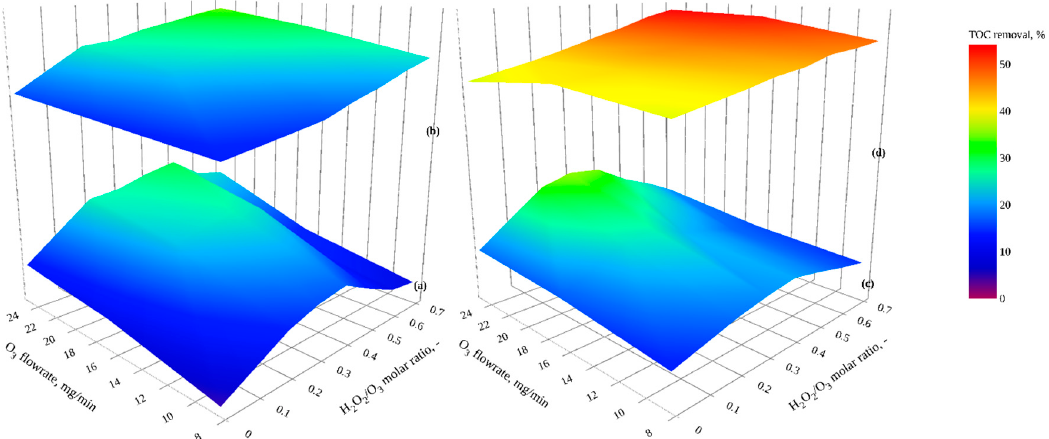
Figure 7. E ff ect of H 2 O 2 / O 3 molar ratios and TiO 2 loading on TOC reduction by ( a ) peroxonation, ( b ) catalytic peroxonation, ( c ) UVA-peroxonation and ( d ) photocatalytic peroxonation (interactive plots presented in Figures S9–S12).